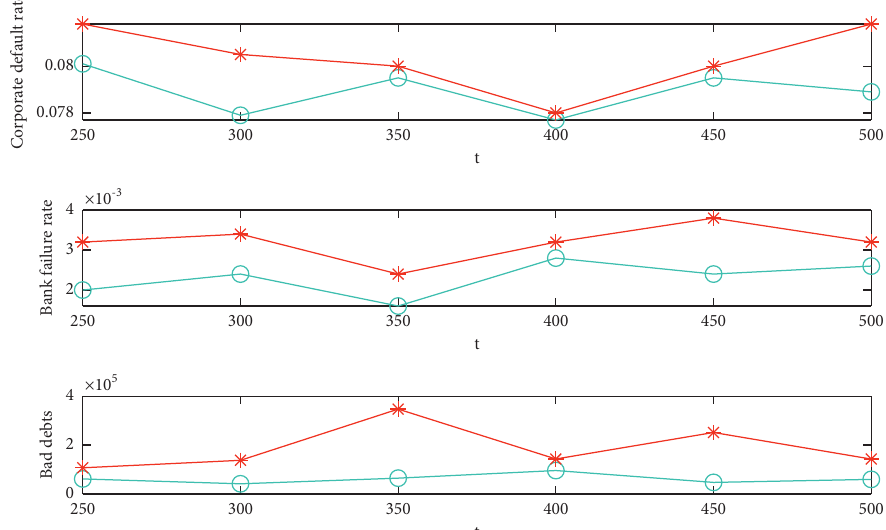
Figure 12: Shocks to the largest asset firms and the evolution of risk contagion between banks and